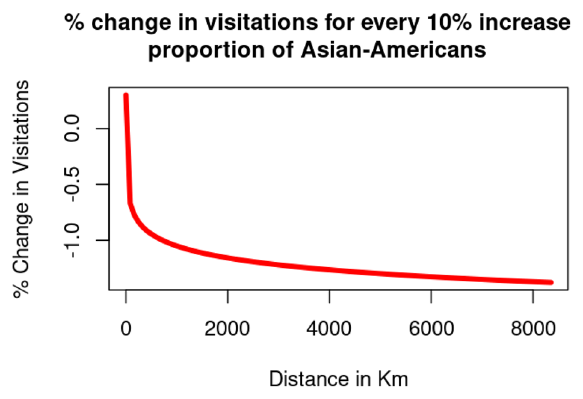
Figure 6. Changes in visitation to each national park for every 10% increase of the proportion of Asian